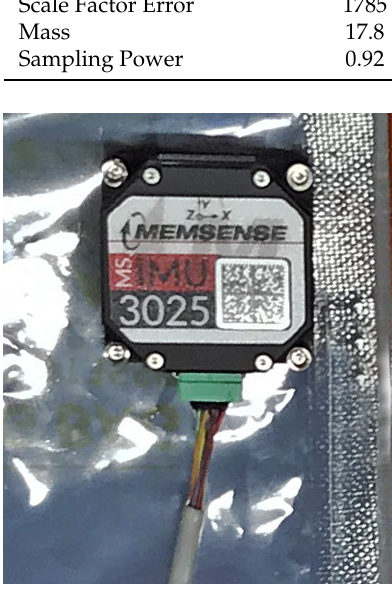
Figure 4. Memsense MS3025M IMU.